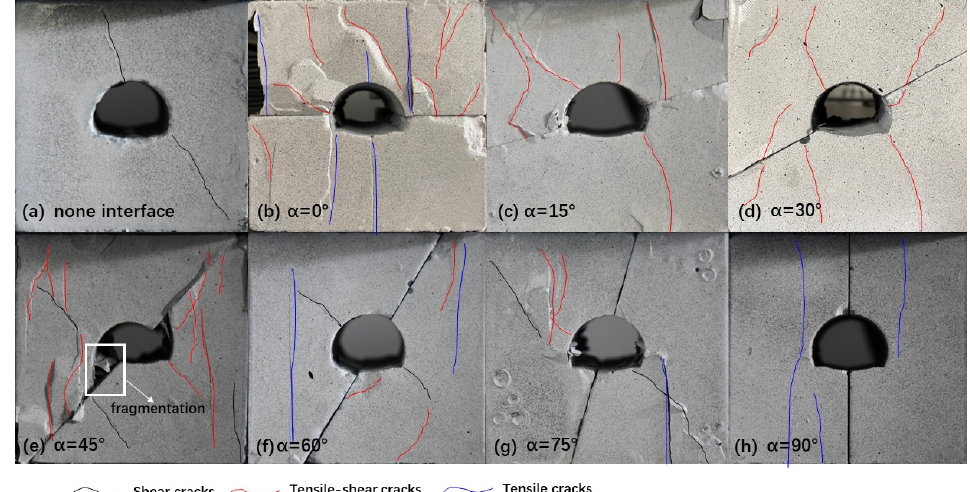
Figure 6. Displacement contour of x direction (unit: 0.01 mm). The black dash line is discontinuous plane. The results were calculated when the sample reached peak strength. The x and y label are the number of pixel points, which is useless for calculation.